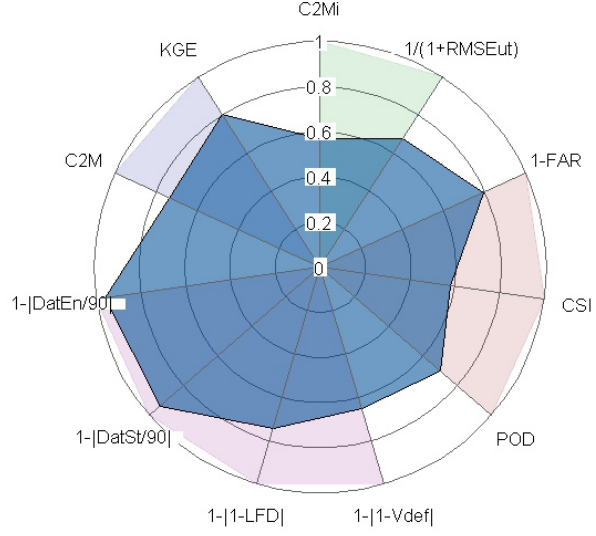
Figure 3. Example of radial plot showing mean model results on the set of 21 catchments for the selected evaluation criteria. The larger the blue surface, the better the model. Background colours link criteria focusing on similar